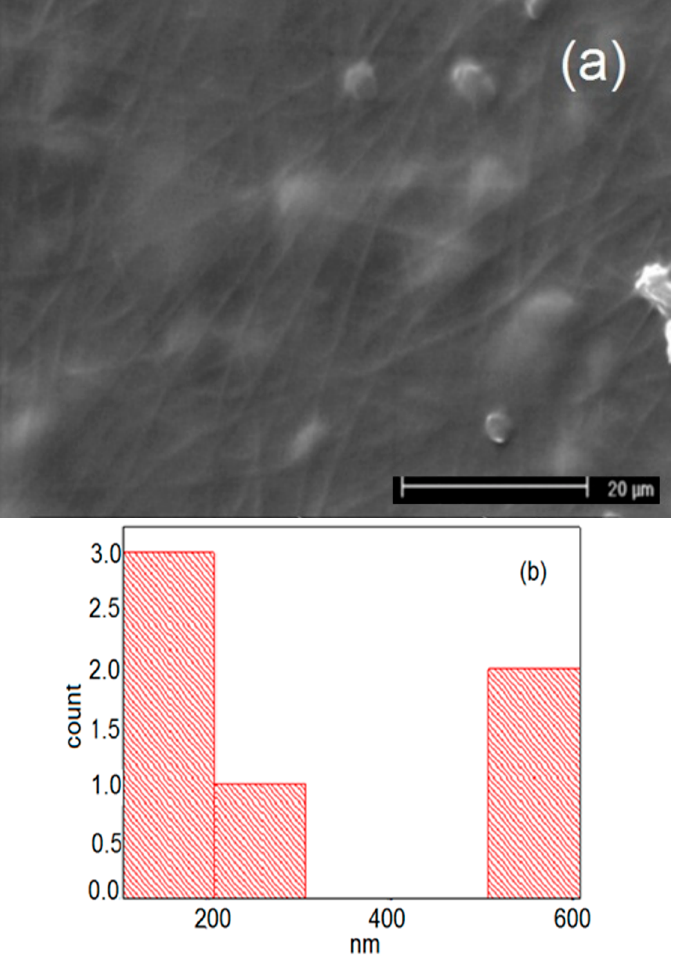
Figure 6. ( a ) SEM images, ( b ) fiber diameter distribution of cross-linked Bup/PVP/PVA nanofiber mats.